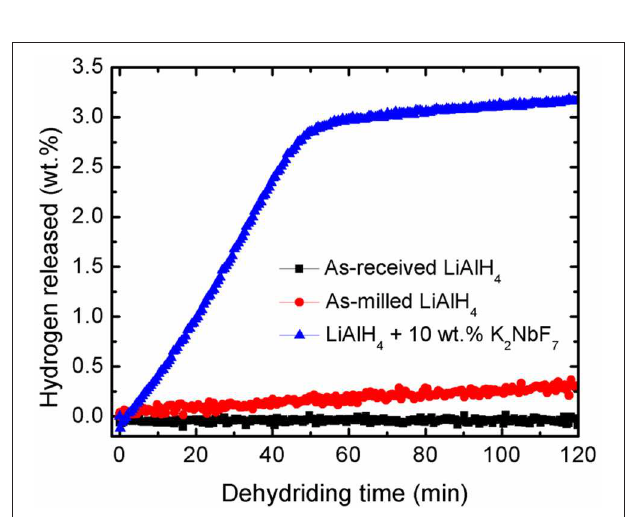
FIGURE 2 | Dehydriding kinetics curves of as-received LiAlH 4 , as-milled LiAlH 4 , and LiAlH 4 + 10 wt.% K 2 NbF 7 at 90 ◦